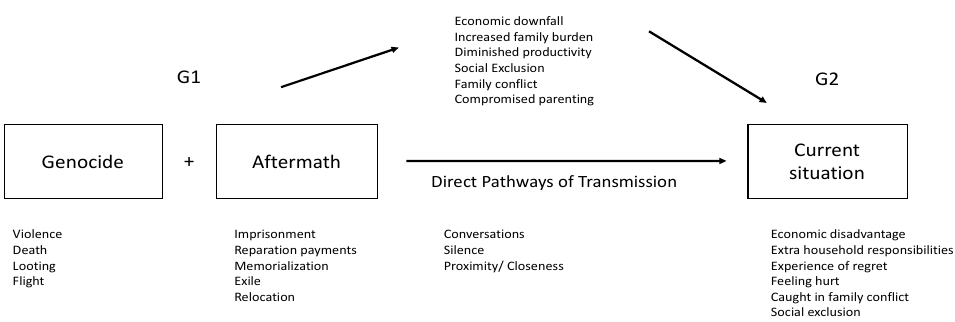
Figure 1. Mechanisms in the intergenerational transmission of legacies of genocide and its aftermath.